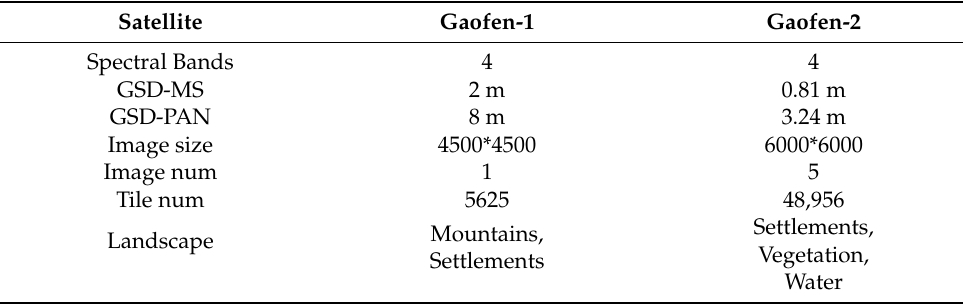
Table 2. The detailed description of Gf-1 and GF-2